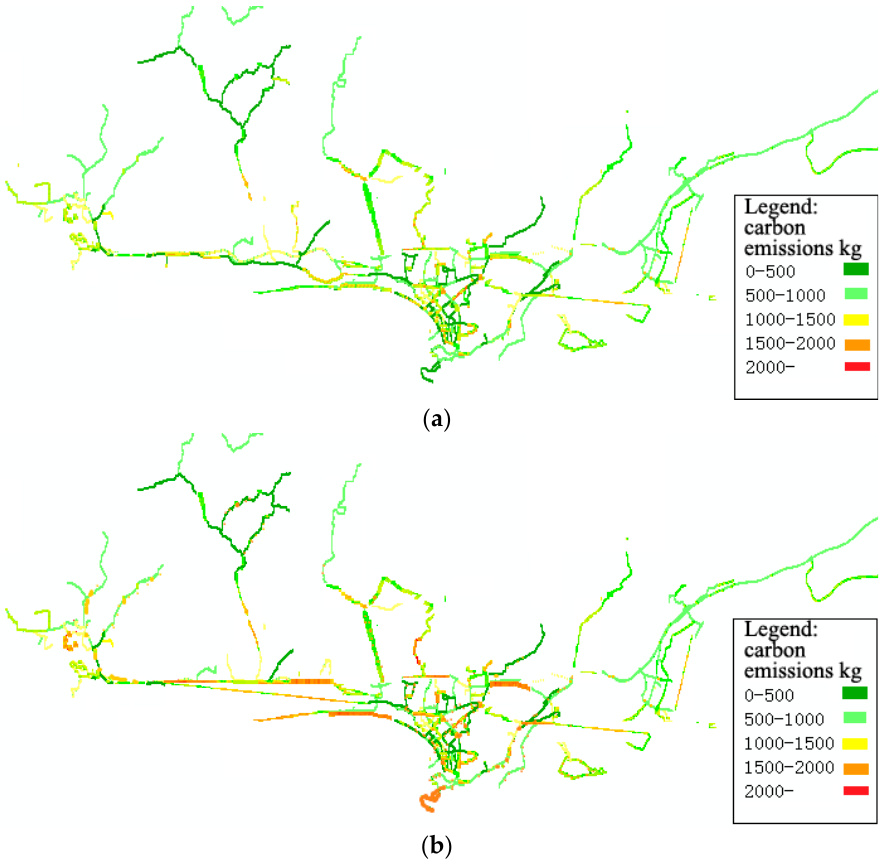
Figure 9. Spatial distribution of buses’ carbon emissions in Sanya on rest days. ( a ) Spatial distribution of the carbon emissions in the morning peak. ( b ) Spatial distribution of carbon emissions in the evening peak.